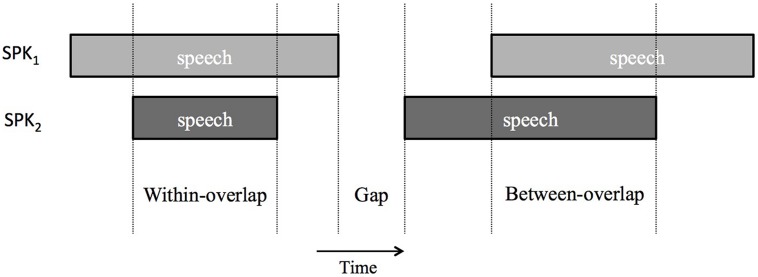
Illustration of gaps, within-overlaps, and between-overlaps for two speakers (SPK1 and SPK2) in our classification scheme following Heldner and Edlund (2010).